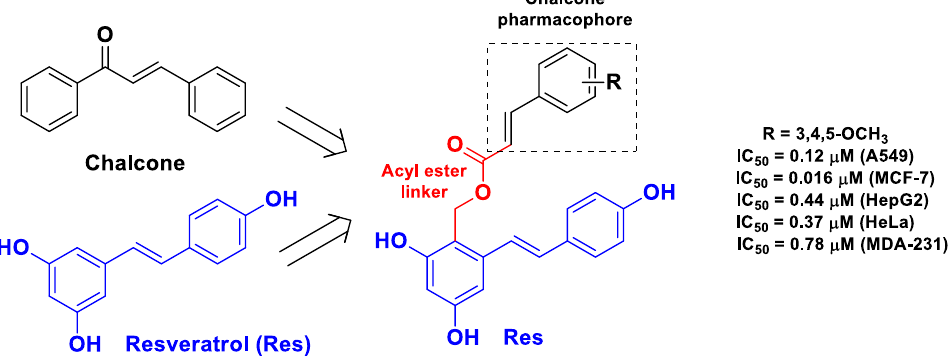
Figure 5. Structure and anticancer activity of the most potent chalcone – Res hybrid developed by Yin et al. [49].